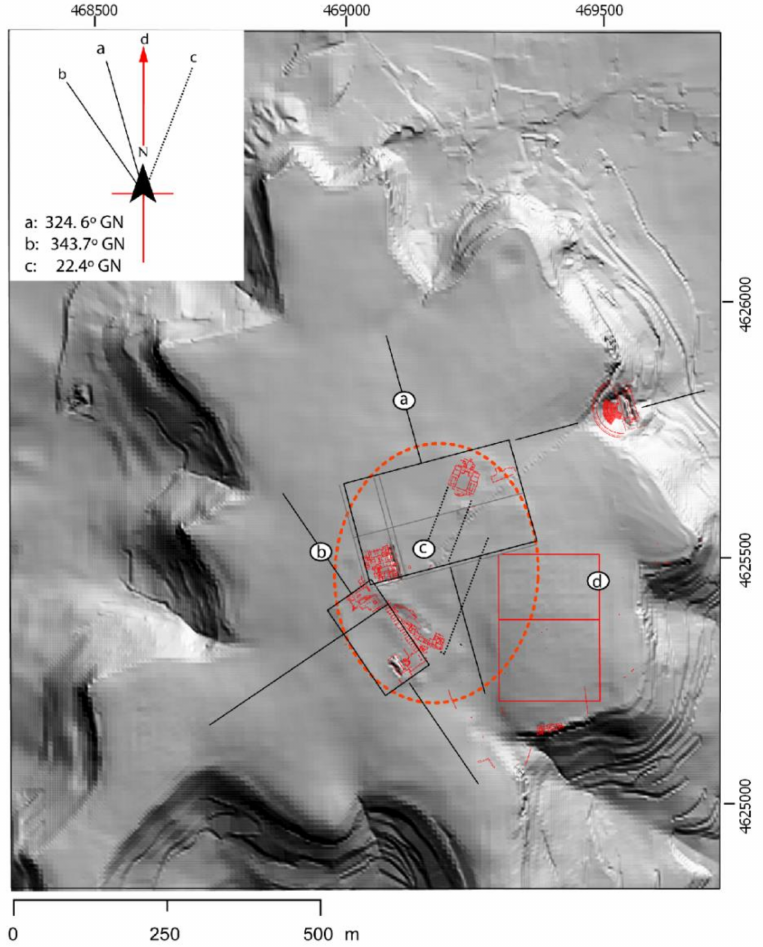
Figure 2. The different urban orientations of the city of Clunia: ( a ) Structure based on the orientation of the theatre and Taracena House; ( b ) Orientation based on the orientation of the forum; ( c ) Orien- tation based on the set of Termas de los Arcos; ( d ) orientation detected in [1]. Source: Hill shading from LiDAR DEM (5 m/pixel)